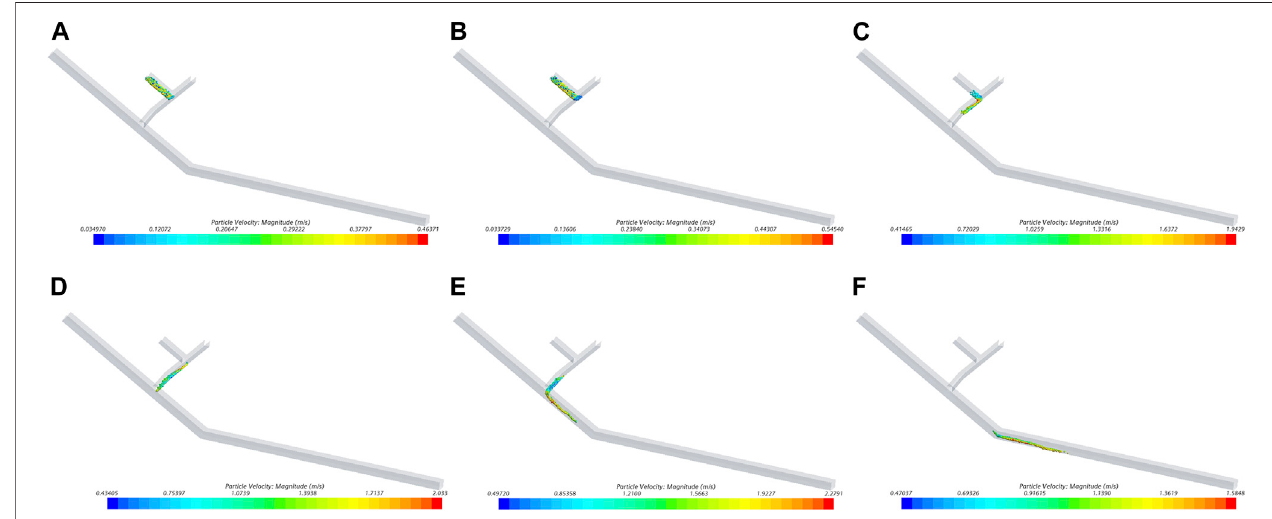
FIGURE 8 | Particle velocity fi eld, gravity erosion: (A) t = 0.5s; (B) t = 1s; (C) t = 1.5s; (D) t = 2s; (E) t = 2.5s; (F) t = 4s.